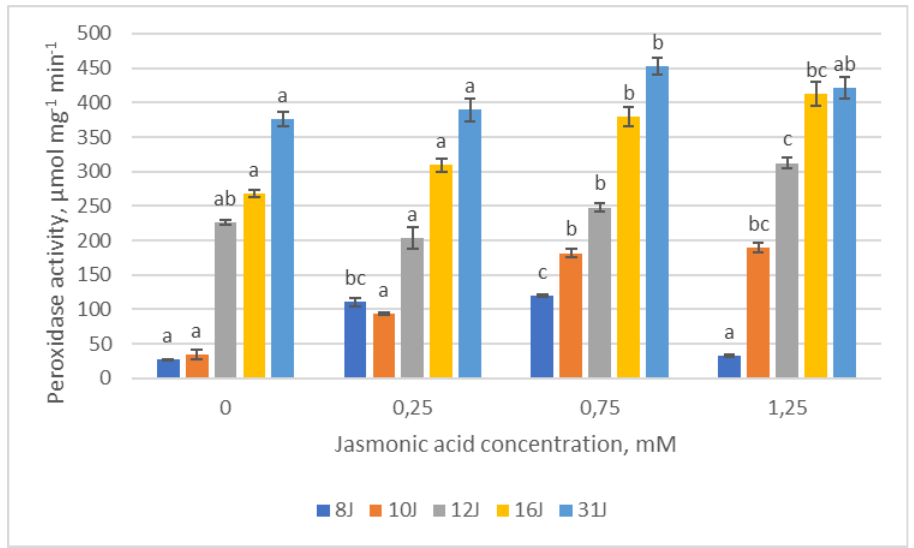
Figure 8. Means (µmol mg − 1 min − 1 ) ± SE of peroxidase (POX) activity in five half-sib families of Scots pine, assessed 6 weeks after sowing. Data significance was calculated using the Kruskal–Wallis H test for ranks and post hoc Dunn’s test for pairs ( p < 0.05). Different letters next to different colors indicate significant differences between the groups, sprayed with different concentrations of jasmonic acid.